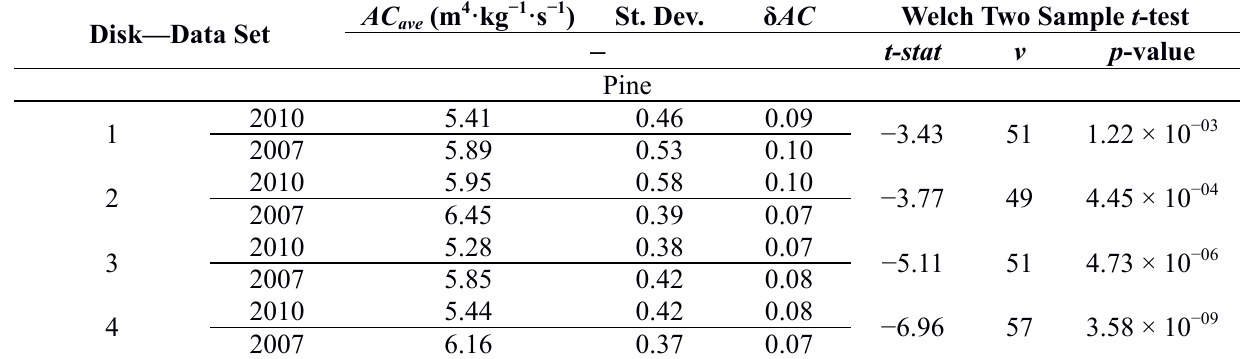
Table 3. Results for acoustic constant